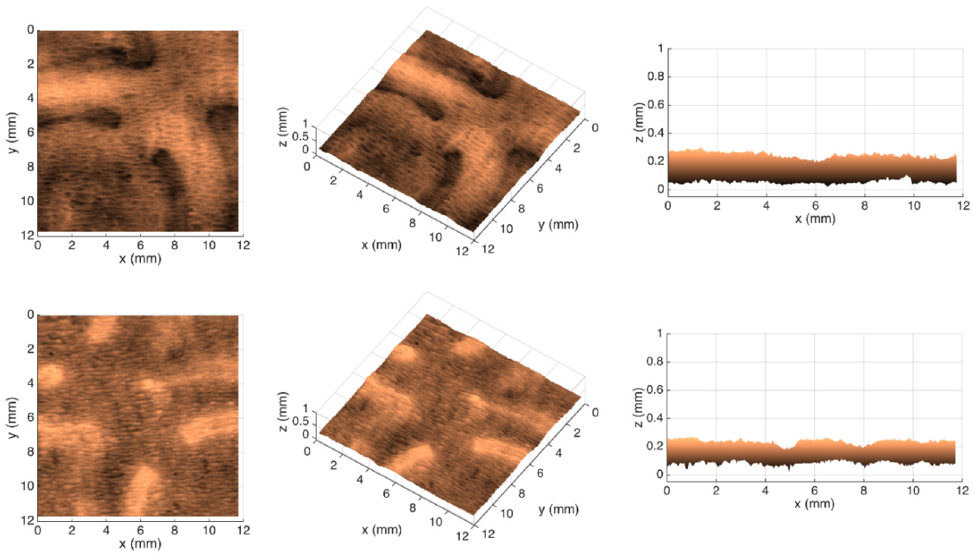
Figure 7. Different views of the 3D maps created for the front and back sides of the tissue-paper sample Bd sl .